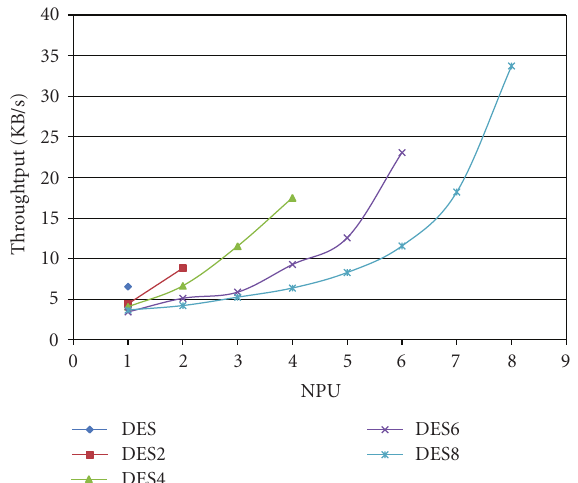
Figure 18: DES performances results with 1, 2, 4, 6, and 8 tasks.